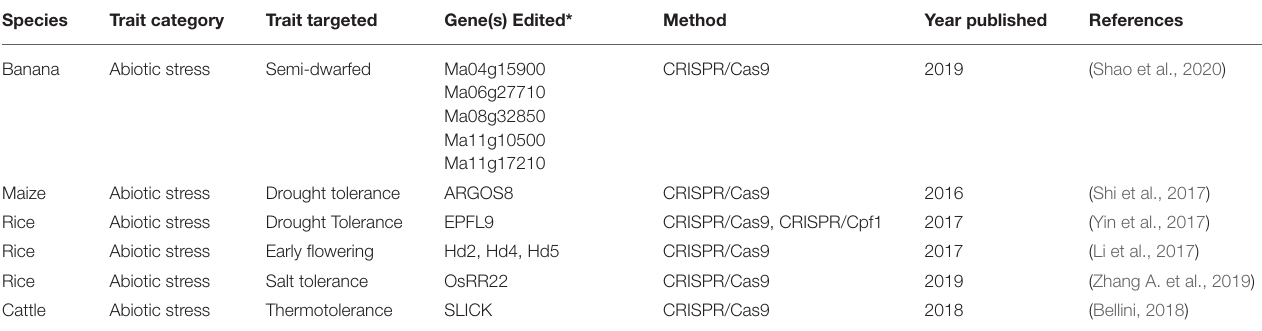
TABLE 1 | Summary of gene-editing applications for abiotic stress.